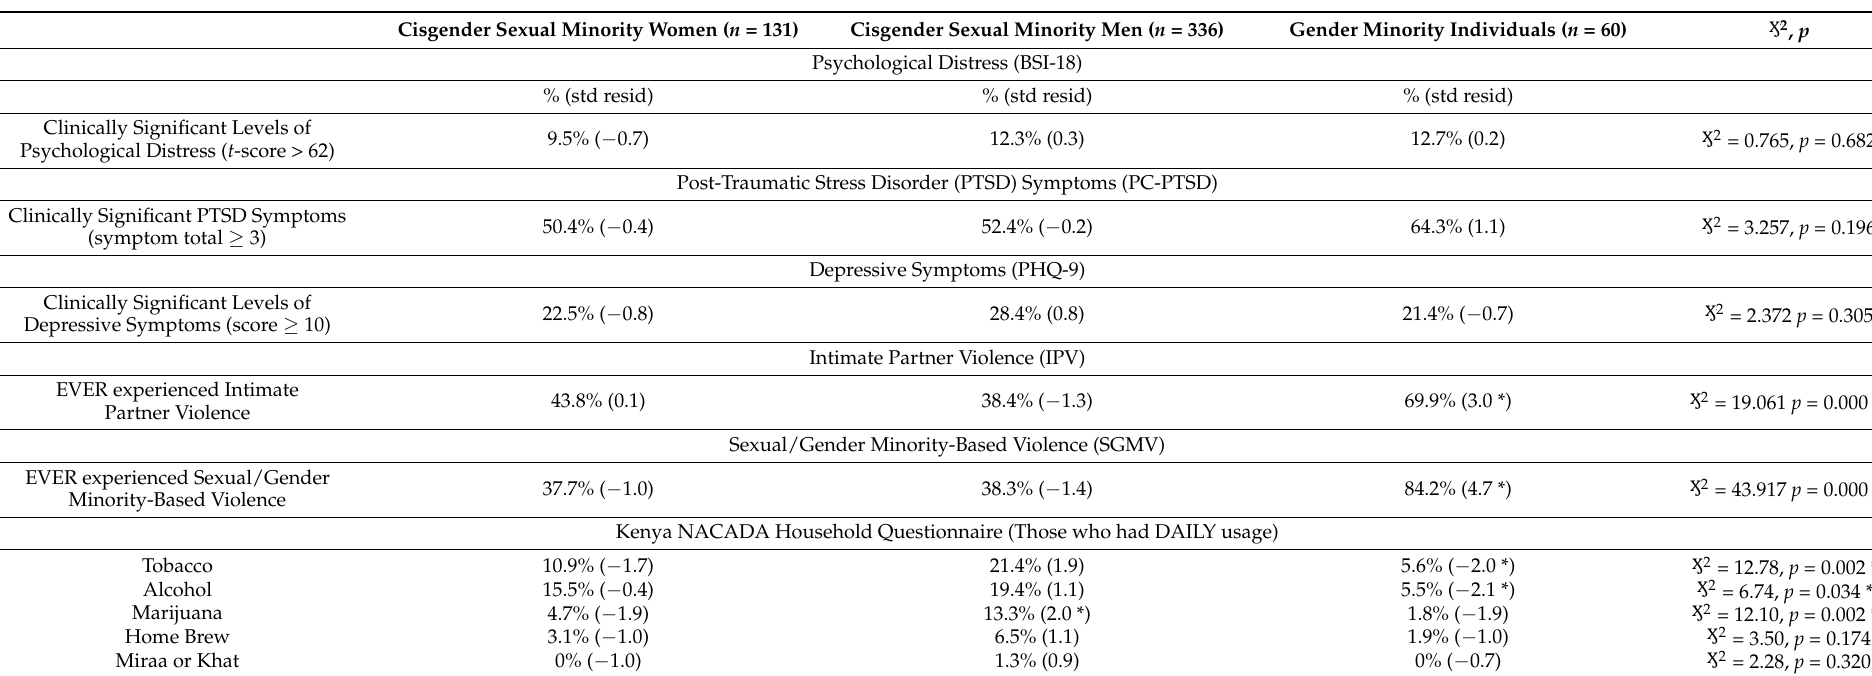
Table 3. Psychological Distress, PTSD Symptoms, Depressive Symptoms, IPV, SGMV, and Problematic Substance and Alcohol Use: Comparison across Sexual Orientation and Gender Identity (SOGI) groups.